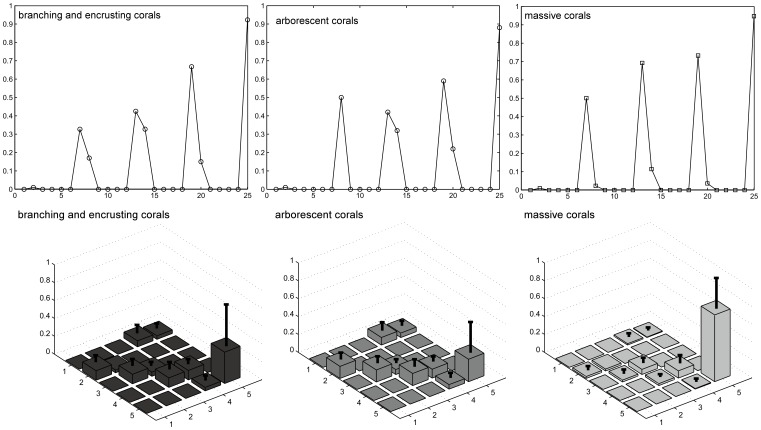
Mean matrices A (upper row) and corresponding elasticity matrices (lower row) for all three growth forms calculated from 10000 Monte-Carlo trials sampling model life tables in five stages.Upper row: The 25 entries of the 5×5 matrix are arranged in column-order. Transitions of settled recruits (A1,1…A5,1) first, then small corals (A1,2…A5,2) and so on. A new size class begins at each multiple of 5 (recruits are at positions 1–5, corals <5 cm at positions 6–10, corals 5–10 cm at positions 10–15, etc). Lower row: Elasticity matrices based on transition matrix including variable recruitment. Expressed as means and standard deviations of all elasticity values obtained by substituting all possible combinations of (1, 10, 100, 1000, 10000) into A
1,4 and A
1,5.